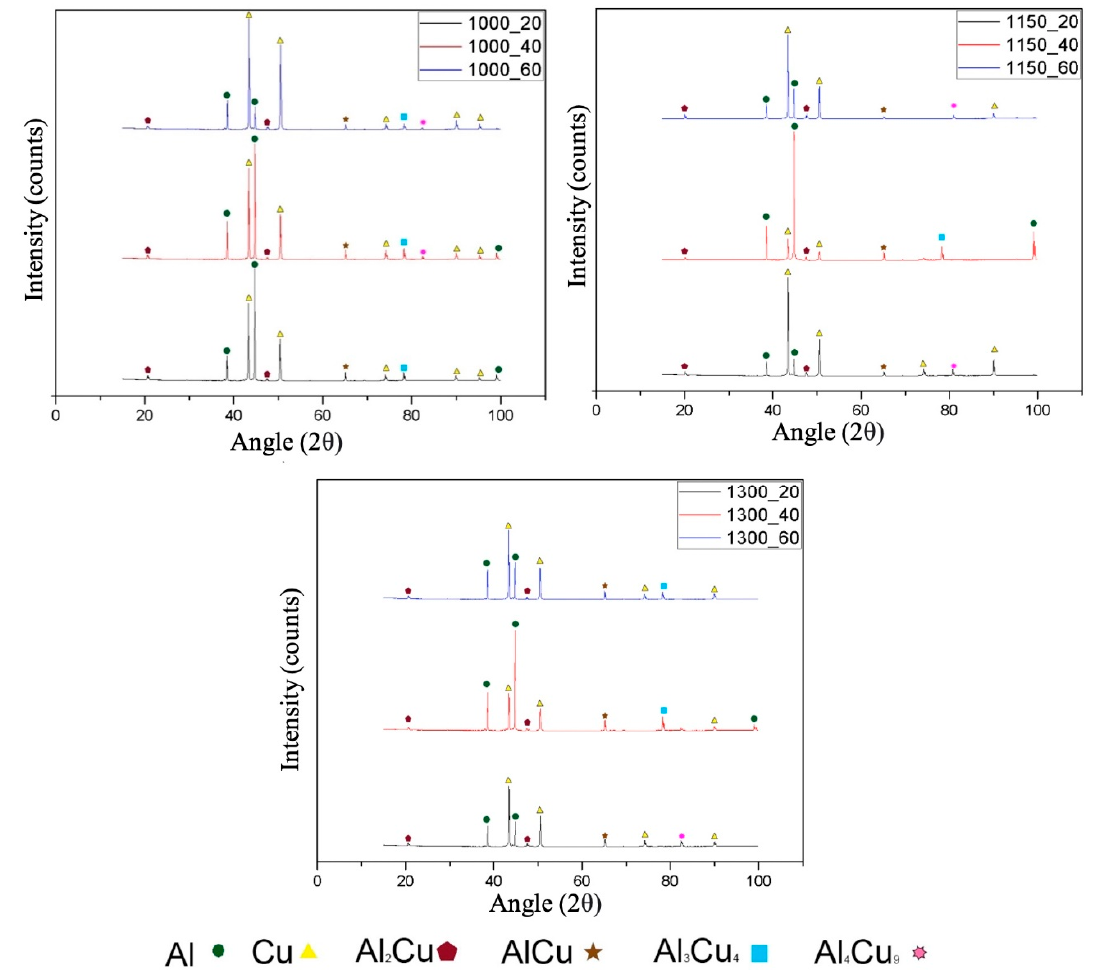
Figure 13. X-ray diffraction patterns of FSW AA 6061-C11000 plates at different welding parameters combination.